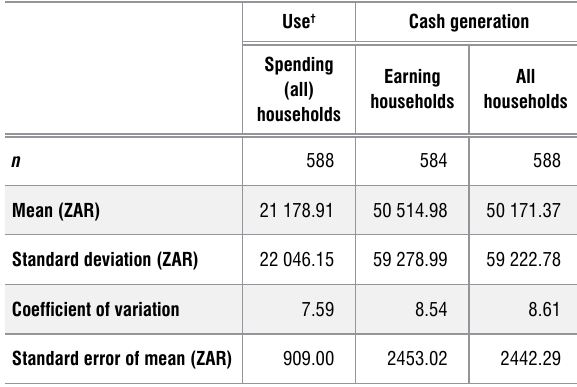
Direct use value of livestock products at Use and Cash Generation points of analysis